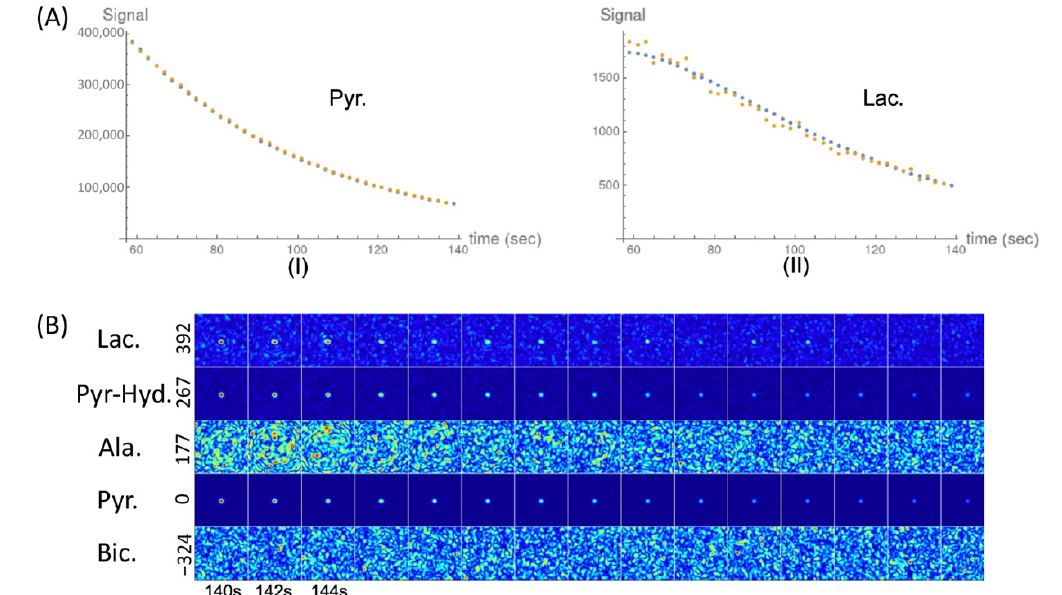
Figure 3. Representative data from an in vitro study. ( A ) Orange dots represent the data for [1- 13 C]pyruvate ( I ) and [1- 13 C]lactate ( II ) obtained from the spectroscopy-based 13 C-MRI acquisition. Blue dots represent best fit lines calculated by kinetic modeling. ( B ) Imaging-based 13 C-MRI acquisition of the investigated metabolites displayed at a temporal resolution of 2 s. Each row represents one metabolite: lactate (chemical shift, 392 Hz), pyruvate–hydrate (267 Hz), alanine (177 Hz), pyruvate (0 Hz), and bicarbonate ( − 324 Hz). Hyperpolarized 13 C signals of lactate, pyruvate–hydrate, and pyruvate were visually